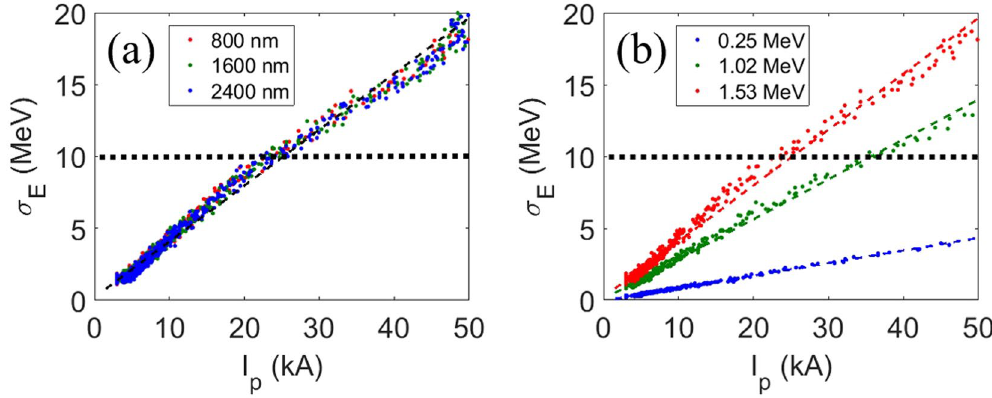
Figure 2. RMS SES ( σ E ) of the current spike vs. peak current of the spike for ( a ) different laser wavelengths λ L at a base SES of 1.53 MeV and ( b ) different base SESs at λ L = 800 nm and a base current of 3 kA. Blue dots are for a base SES of 0.25 MeV (ref. 33 ) with a fitting of σ E = 0.0879 I P − 0.0620 by regression (blue dashed line). Green dots are for a base SES of 1.02 MeV with a fitting of σ E = 0.2783 I P + 0.0591 regression (green dashed line). Red dots are for a SES of 1.53 MeV (as in Fig. 2(a)). Horizontal black dashed lines represent the limit of SES of the current spike, below which an appropriate lasing process is expected from Eq. (1) (the ‘Methods’ section for the detail simulation